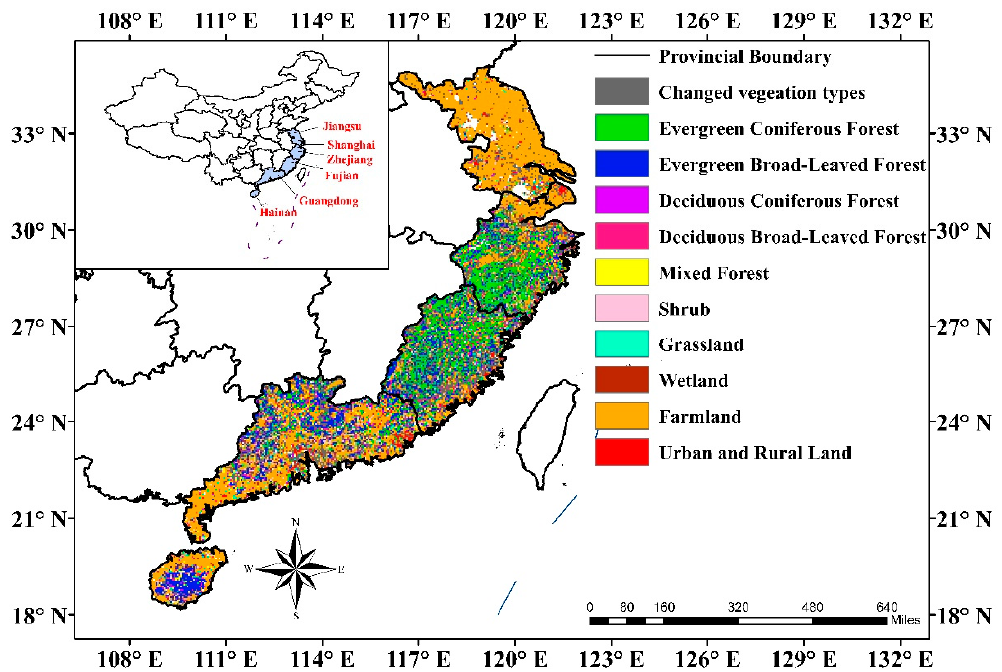
Figure 3. Unchanged (evergreen broad-leaved forest, deciduous broad-leaved forest, evergreen co- niferous forest, deciduous coniferous forest, mixed forest, farmland, wetland, grassland, shrub, ur- ban and rural land) and changed vegetation types in the study area during 1992–2015. The white areas in the study area representing the non-vegetation